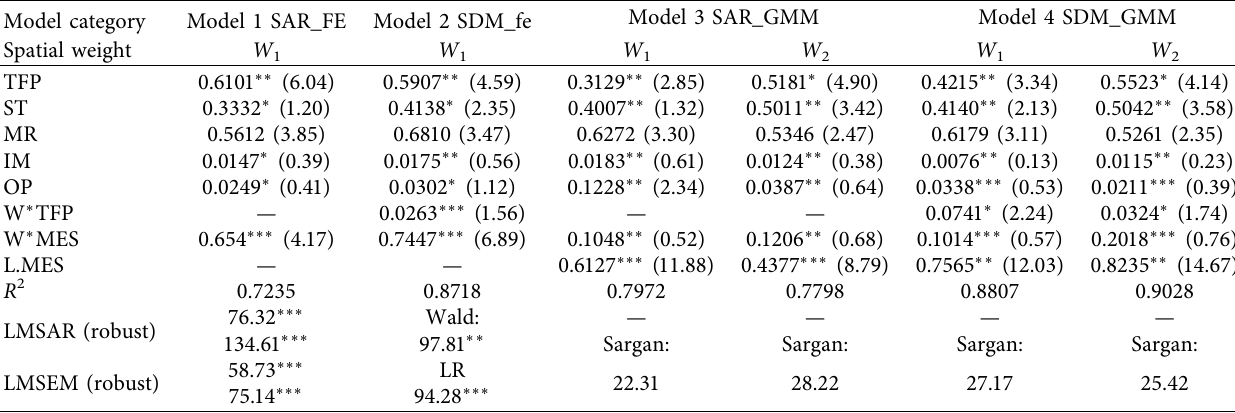
Table 6: Estimated results of the spatial measurement